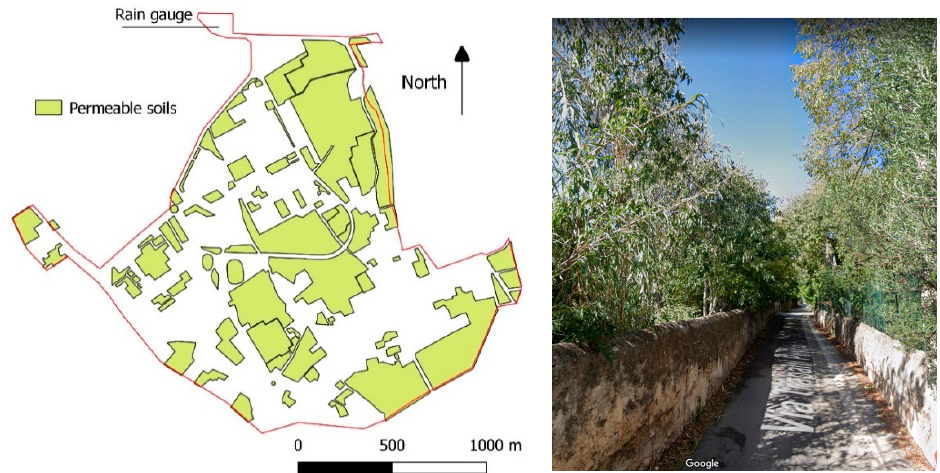
Figure 5. Permeable soils inside the computational domain ( left ). Street view (Google) of boundary walls of permeable soil ( right ).